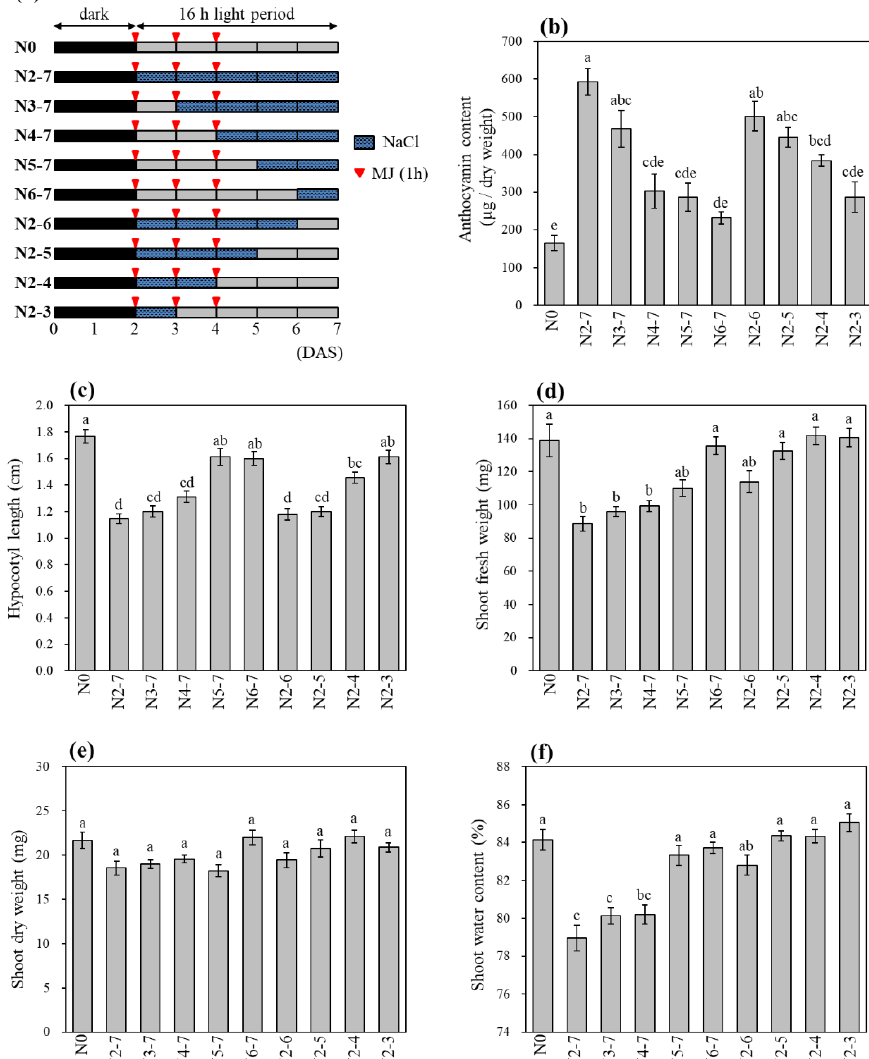
Figure 7. Effect of salinity (200 mM NaCl) treatment periods on the growth of radish sprouts co- treated with MJ (0.5 mM). ( a ) Schematic designs of this experiment. Anthocyanin content ( b ), hypocotyl length ( c ), shoot fresh weight ( d ), shoot dry weight ( e ), and shoot water content ( f ) were measured in the sprouts of each treatment at 7 DAS. Error bars represent ± SE ( n = 9). Different letters indicate significant differences by Tukey’s multiple comparison test ( P < 0.05).